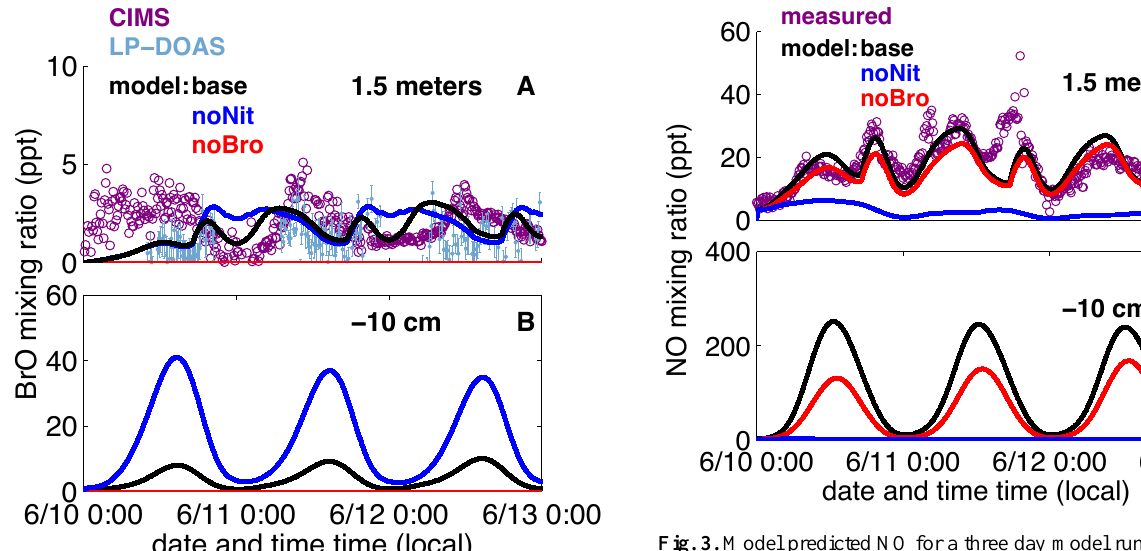
Fig. 3. Model predicted NO for a three day model run for the base, noNit, and noBro cases compared to measurements of NO taken on 10–13 June 2008. Without bromide in the liquid layer, the amount of NO predicted decreases. Without snow sourced NO x enhanced NO is not predicted in the interstitial air and ambient NO is predicted to be well below measured